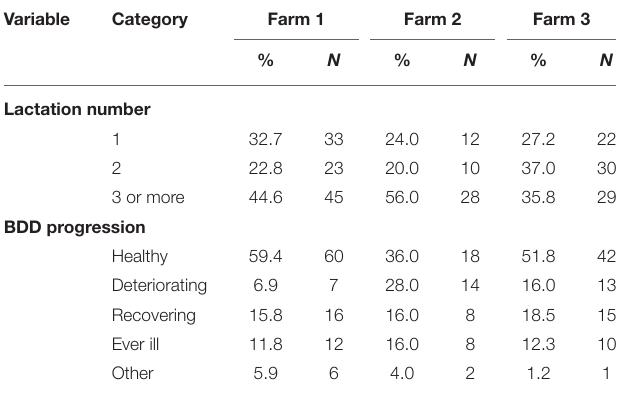
TABLE 2 | Distribution of sample population according to lactation number and BDD progression type per